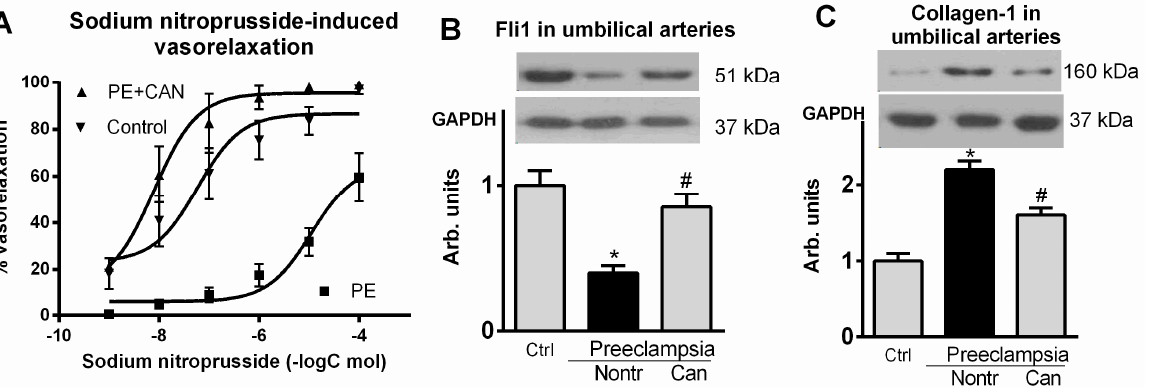
Figure 4. ( A )—Effect of normotensive pregnancy, control (EC 50 = 58 ± 14 nmol/L), PE alone (EC 50 = 58 ± 14 nmol/L; p < 0.01 vs. contol) and PE with canrenone (EC 50 = 40 ± 7 nmol/L, p < 0.01 in PE) on the responsiveness of umbilical artery rings to sodium nitroprusside-induced vasorelaxation following contractions induced by 100 nmol/l endothelin-1, concentration–response curves were determined 5 times and averaged to give means and SEM for IC 50 . Effects of the normotensive pregnancy (Ctrl), PE (Nontr) and PE plus canrenone (Can) on ( B ) levels of Fli1 and ( C ) collagen-1 in umbilical arteries. Top analysis. Each bar represents individual samples pooled and averaged to give means and SEM of 5 measurements. By one-way ANOVA followed by Bonferroni test: * p < 0.01 versus nontr. # p < 0.01 vs. can.